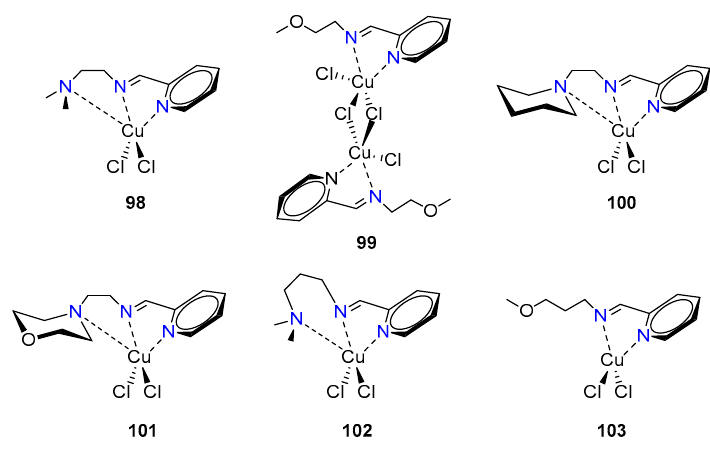
Figure 17. Cu(II)-iminomethylpyridine complexes 98–103 [67].